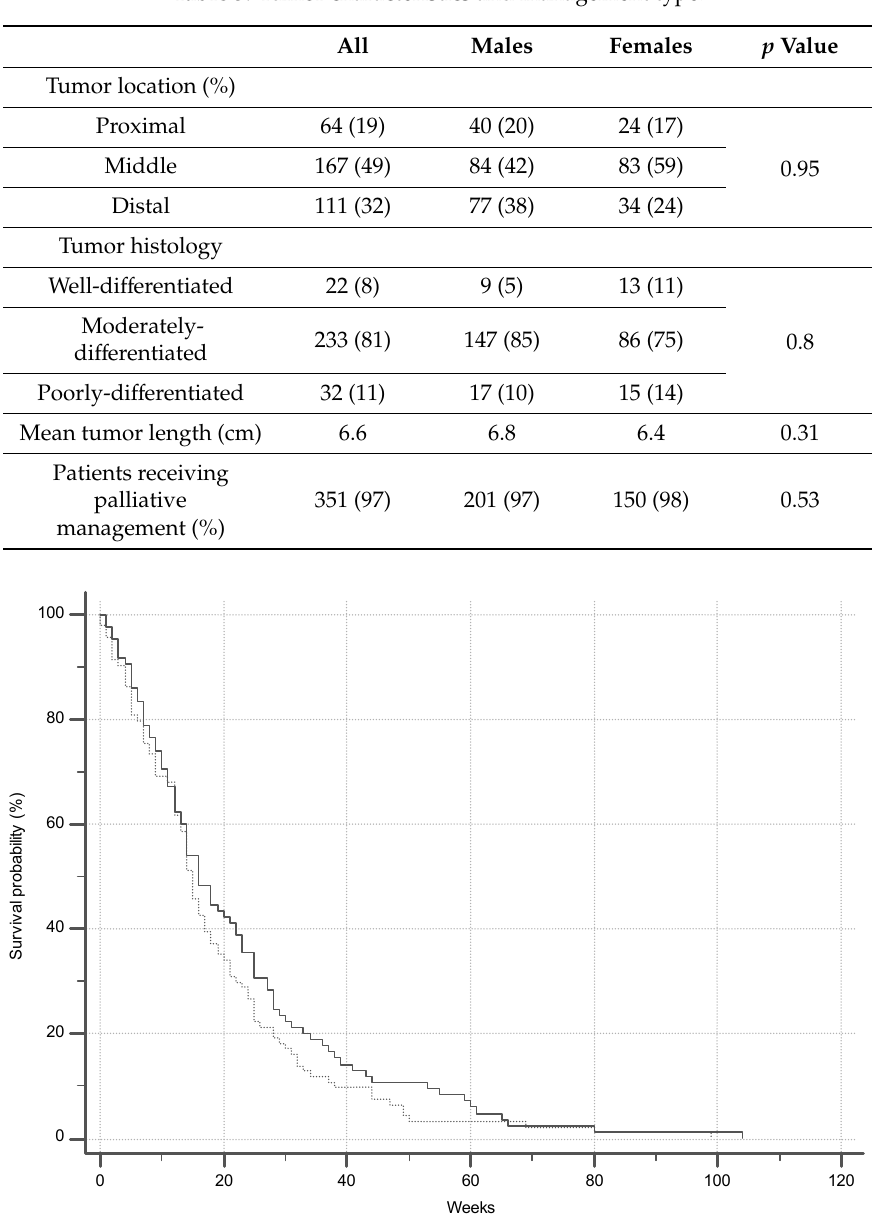
Figure 2. Survival in group of confirmed deaths. Table 3. Tumor characteristics and management type.